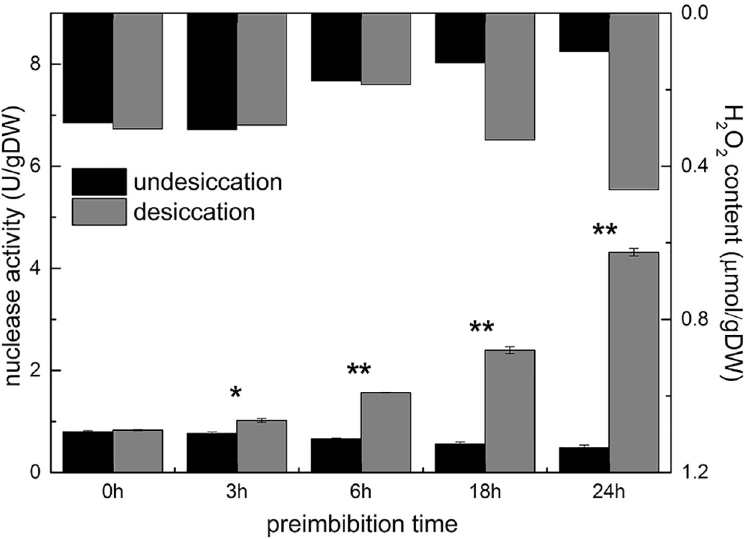
Fig 8. Activity of total nuclease from mung bean hypocotyls in different preimbibition and dehydration states. � P < 0.05; �� P <